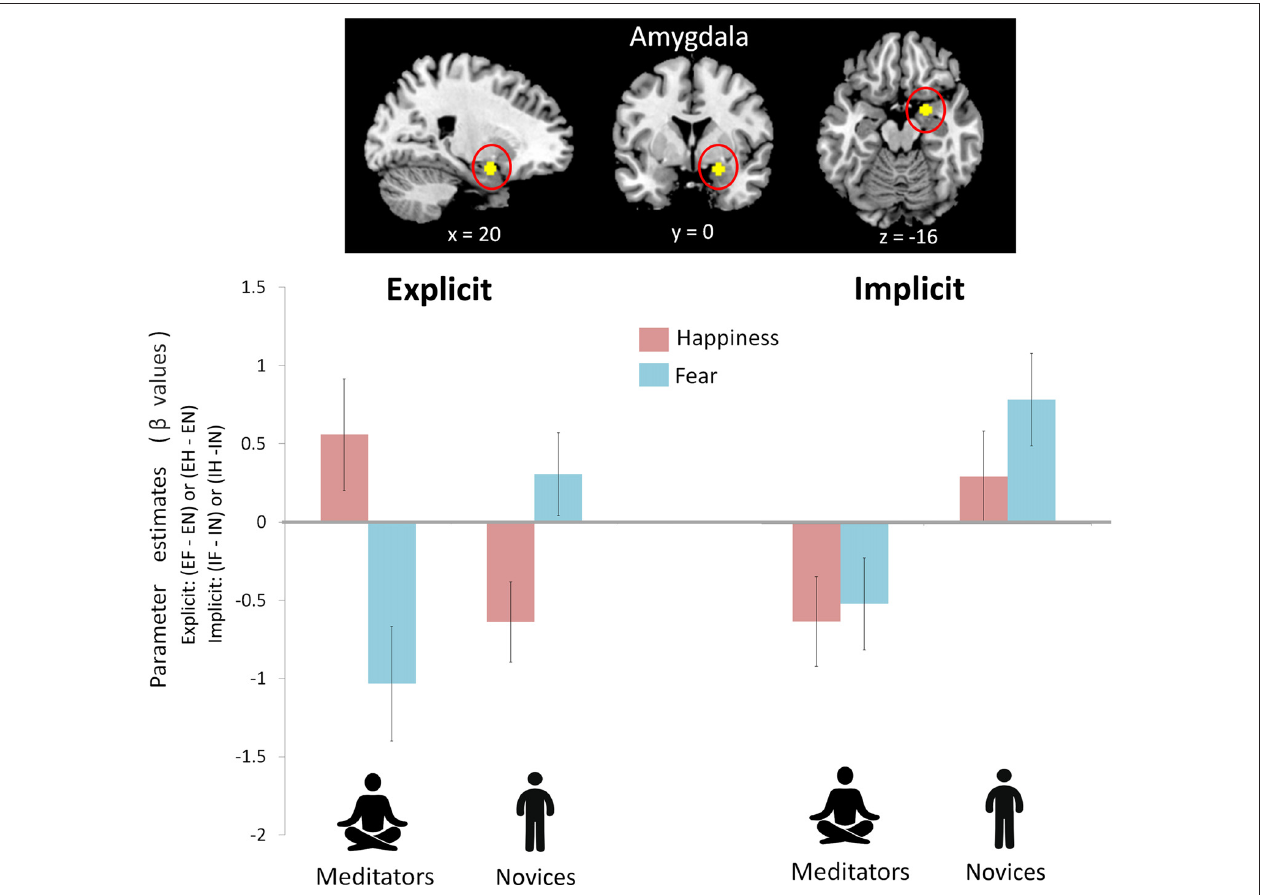
FIGURE 2 | Amygdala reactivity between mediators and novices during explicit and implicit emotional processing. A prior region of interest (ROI)-based beta estimates were extracted from the amygdala. There was an interaction of group (mediators vs. novices) × attention (explicit vs. implicit) × emotion (happiness vs. fear; F ( 1,39 ) = 4.91, p = 0.033). Post hoc analysis indicated a group × emotion interaction during the explicit condition ( p = 0.001) and a group effect during the implicit condition ( p < 0.001). During the explicit condition, to perceived happiness compared with fear (EH − EF), amygdala reactivity was increased in the meditators but was decreased in the novices. During the implicit condition, compared with the novices, the meditators showed significantly weaker amygdala reactivity regardless of fear or happiness.